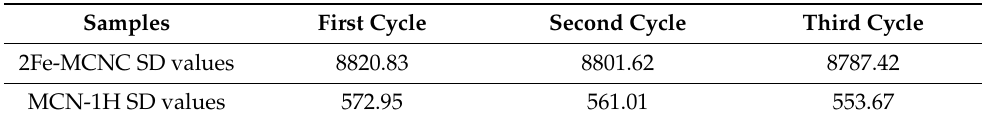
Figure 9. ( a , b ) The photocatalytic H 2 evolution of the MCN and Fe-MCNC nanostructures, ( c ) the recycling stability experiments of 2Fe-MCNC for photocatalytic H 2 evolution. Table 3. Standard deviation (SD), determined for the reproducibility study of the representative